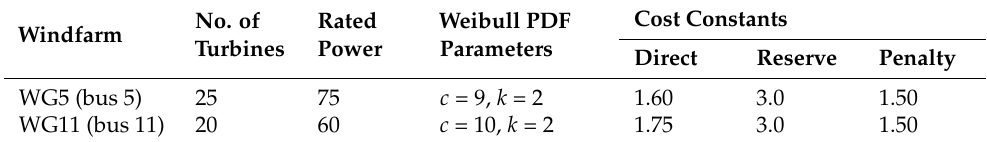
Table 2. PDF constants of wind power plants [23].